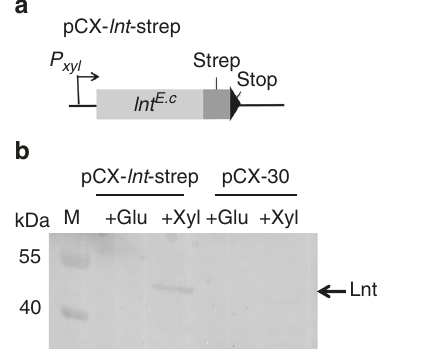
Fig. 3 Expression of E. coli -speci fi c lnt gene in S. carnosus . ( a ) Plasmid construct: in pCX- lnt -strep, the E. coli -derived lnt carries a strep-tag sequence and two 3 ′ stop codons; its expression is xylose inducible and glucose repressible. ( b ) Western blot with membrane fractions generated from S. carnosus (pCX- lnt -strep) and S. carnosus (pCX30) cultivated in B medium supplemented with either 0.25% glucose (causes lnt repression) or 0.25% xylose (causes lnt induction); Lnt was targeted with α -strep-tag